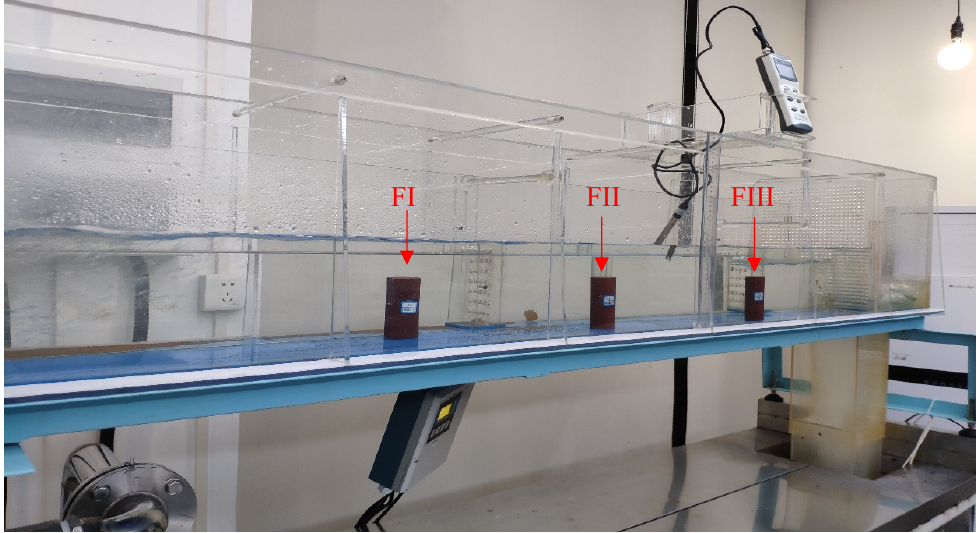
Figure 4. State diagram of the low-temperature (1 °C) test under dynamic water conditions.